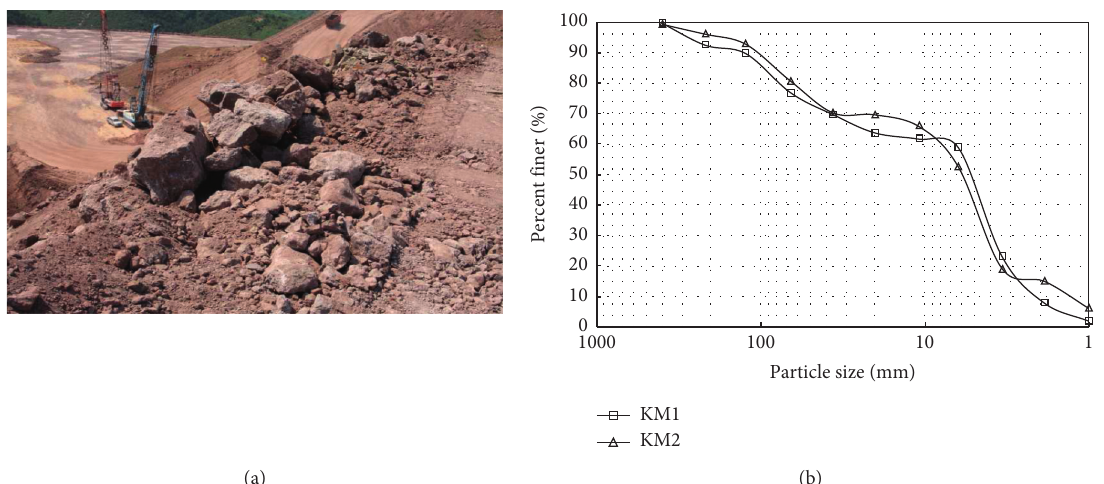
Figure 5: (a) Rock-soil mixture at high fill construction site for Chengde Airport. (b) The typical particle size distribution of gap-graded high fill for Kunming New Airport.